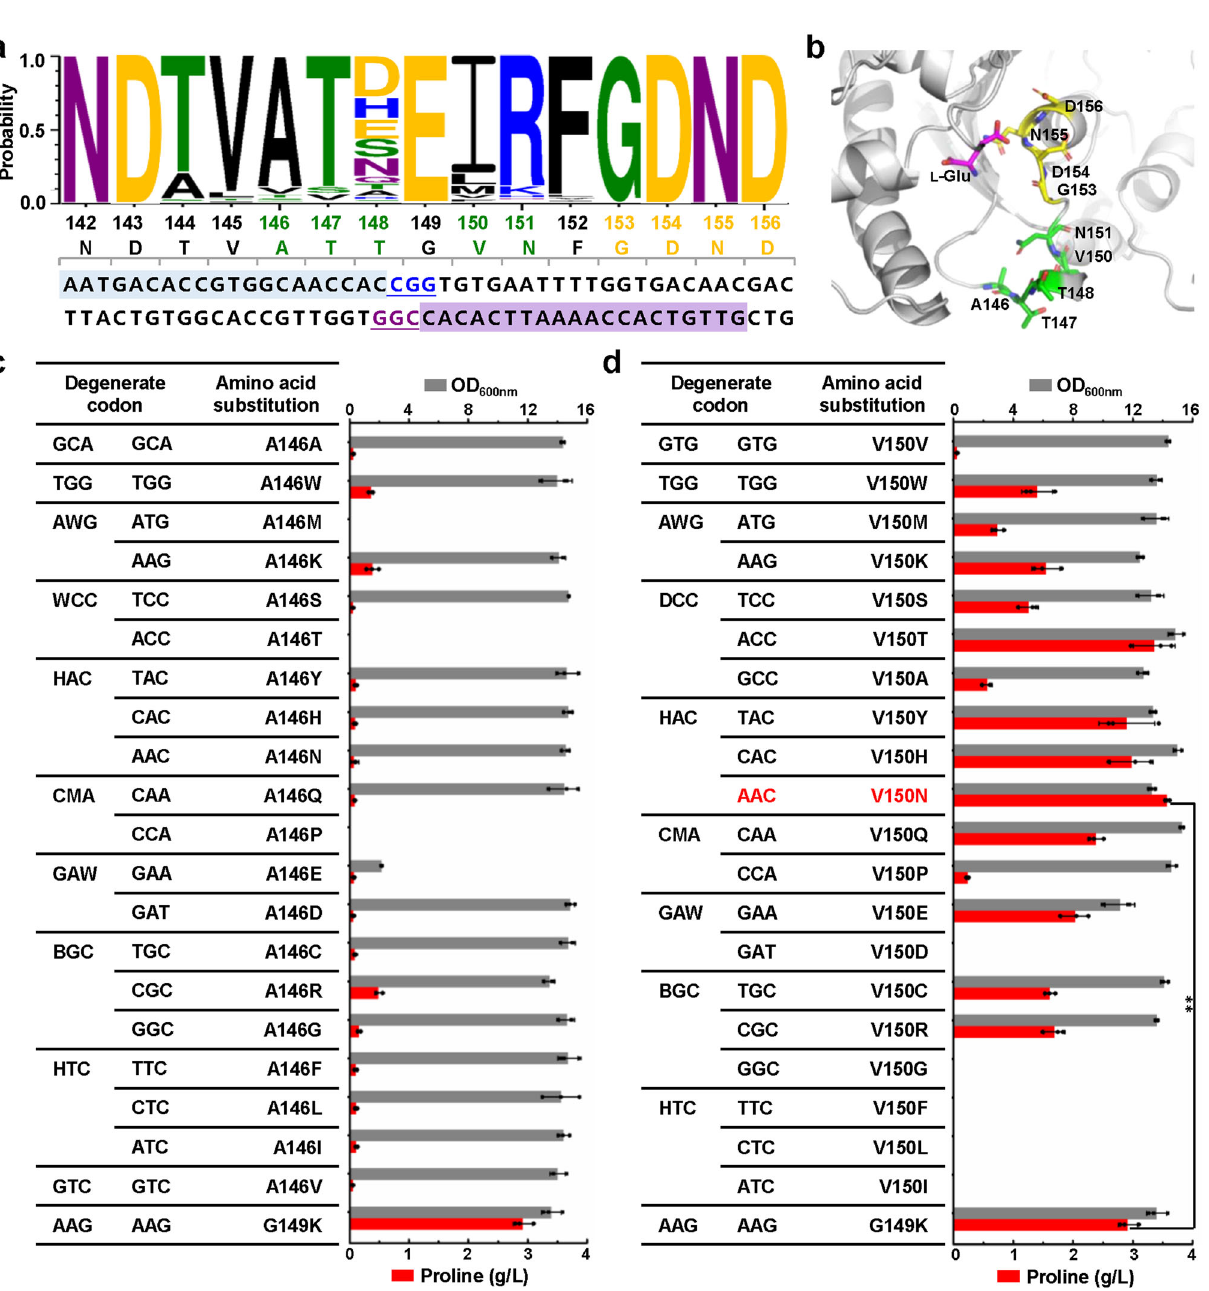
Fig. 3 Codon saturation mutagenesis of γ -glutamyl kinase of C. glutamicum (CgProB) for improved L -proline production via CRISPR/Cas9-assisted ssDNA recombineering. a Conservation analysis of γ -glutamyl kinases. The conserved region involved in L -proline binding is indicated in yellow. The A146, T147, T148, V150, and N151 residues mutated in this study are highlighted in green. The two gRNAs used and their corresponding PAM sequences (underlined) are highlighted in blue and purple, respectively. γ -Glutamyl kinases sequences used for conservation analysis are provided in Supplementary Data 1. b The model structure of CgProB. The model structure was constructed with the crystal structure of γ -glutamyl kinase from E. coli (PDB ID: 2J5T) 80 as a template (93% coverage and 38% sequence identity with CgProB) using Discovery Studio 2018 software. The backbone of CgProB is shown in a ribbon model on which several key residues are shown in a stick model. The substrate L -glutamate is indicated in magenta. The conserved amino acid residues G153, D154, N155, and D156 are indicated in yellow. The engineered amino acids residues A146, T147, T148, V150, and N151 are indicated in green. The full structure is shown in Supplementary Fig. 5. c Growth and L -proline production by C. glutamicum strains with amino acid substitution at codon 146 of CgProB. The strain harboring reported CgProB G149K mutation 35 was used as a control. L -Proline production was conducted in 96-deep-well plates. Data are presented as mean values + / − SD ( n = 3 independent experiments). d , Growth and L -proline production by C. glutamicum strains with amino acid substitution at codon 150 of CgProB. The strain harboring reported CgProB G149K mutation 35 was used as a control. The V150N mutation used in strain PRO-1 is indicated in red. L -Proline production was conducted in 96-deep-well plates. Data are presented as mean values + / − SD ( n = 3 independent experiments). ** P = 0.0024, Student ’ s two-tailed t -test. Source data underlying Fig. 3c, d are provided as a Source Data fi le.